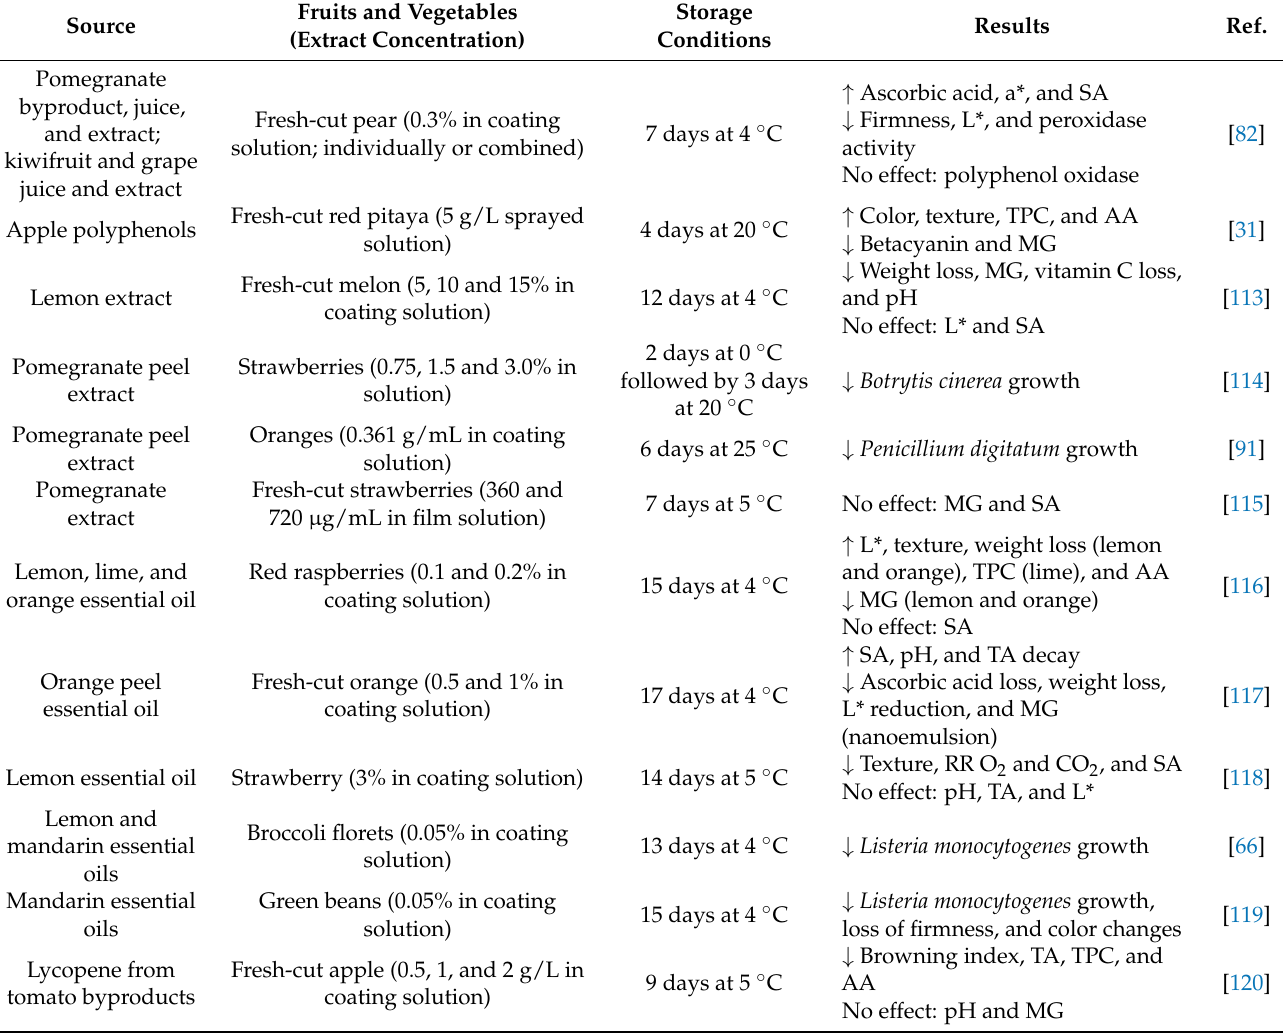
Table 7. Preservative effect of fruit bioactive compounds in fruits and